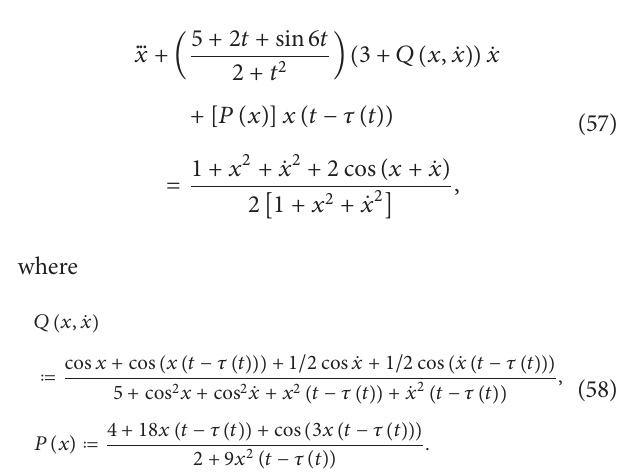
Figure 2: Functions 𝑓(⋅)